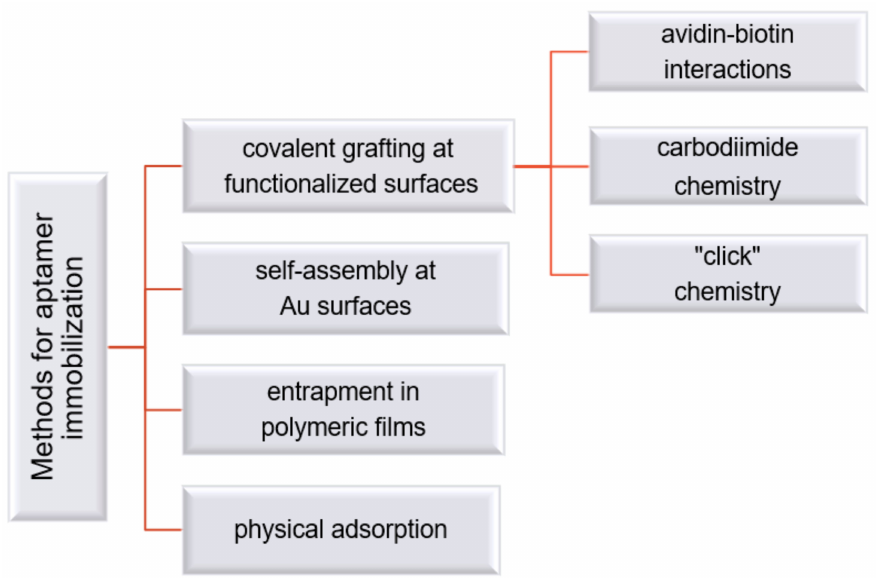
Scheme 1. Different approaches reported for the aptamer immobilization for developing electro- chemical aptasensors for food safety